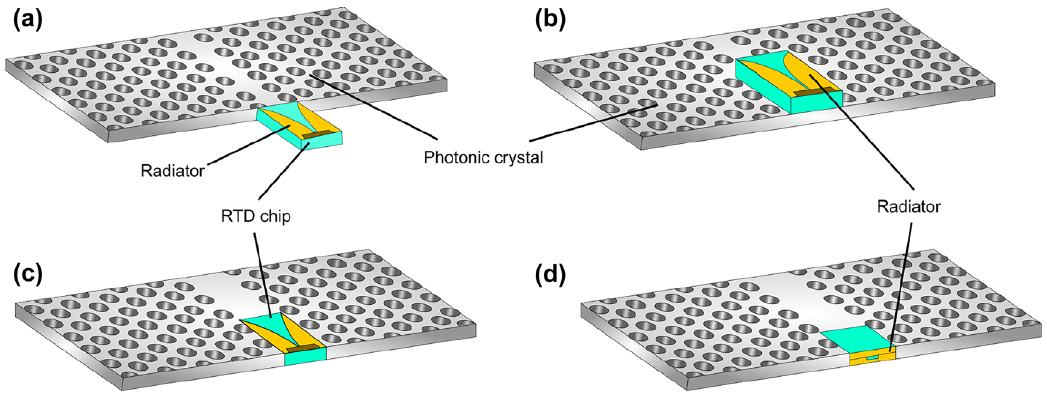
Figure 4: Coupling schemes for hybrid integration with RTD, (a) end-fire coupling, (b) parallel coupling, (c) embed coupling, and (d) backside